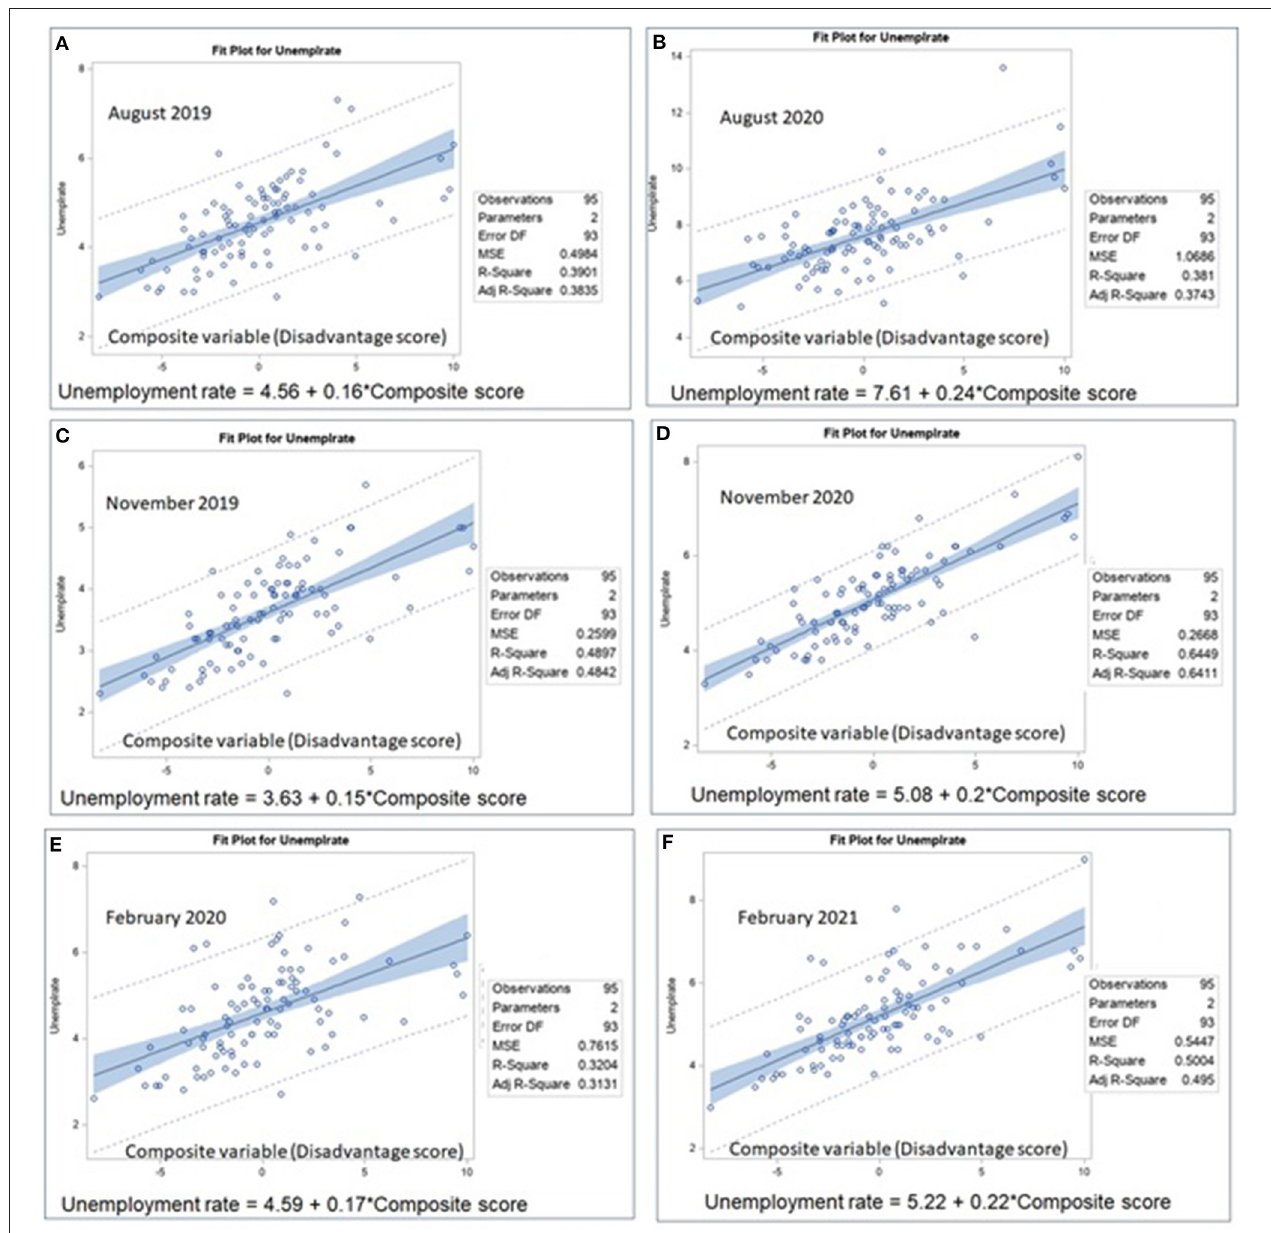
FIGURE 6 | Line fit plots for an unemployment and social disadvantage for TN counties for before- and post-COVID-19: (A) August 2019; (B) August 2020; (C) November 2019; (D) November 2020; (E) February 2020; (F) February 2021.